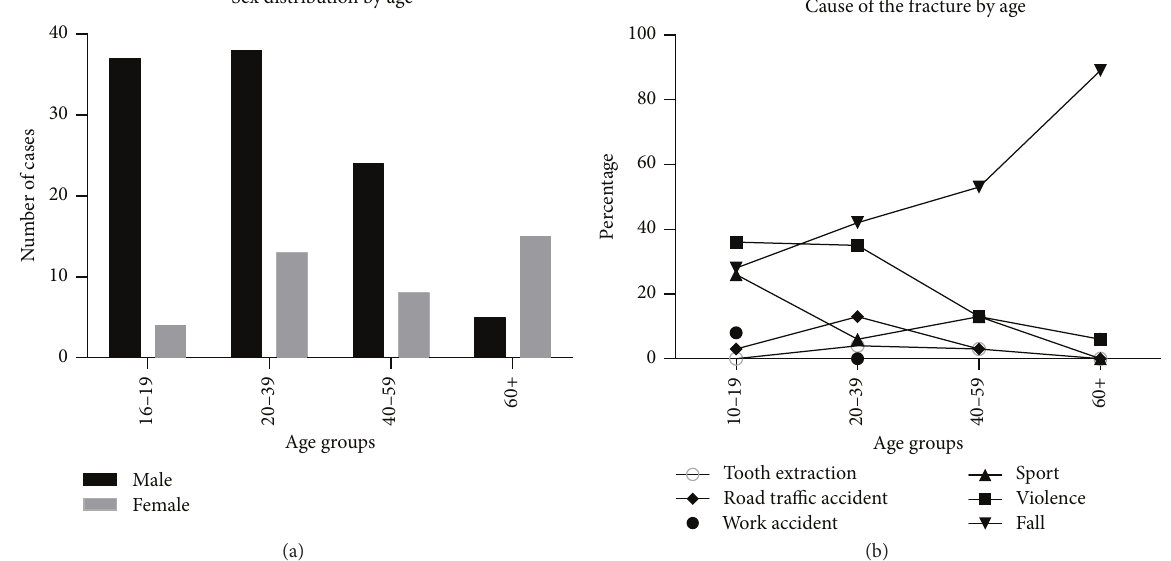
Figure 3: (a) Proportions of men (black) and women (grey) in each age group. (b) Causes of the fracture by age group.